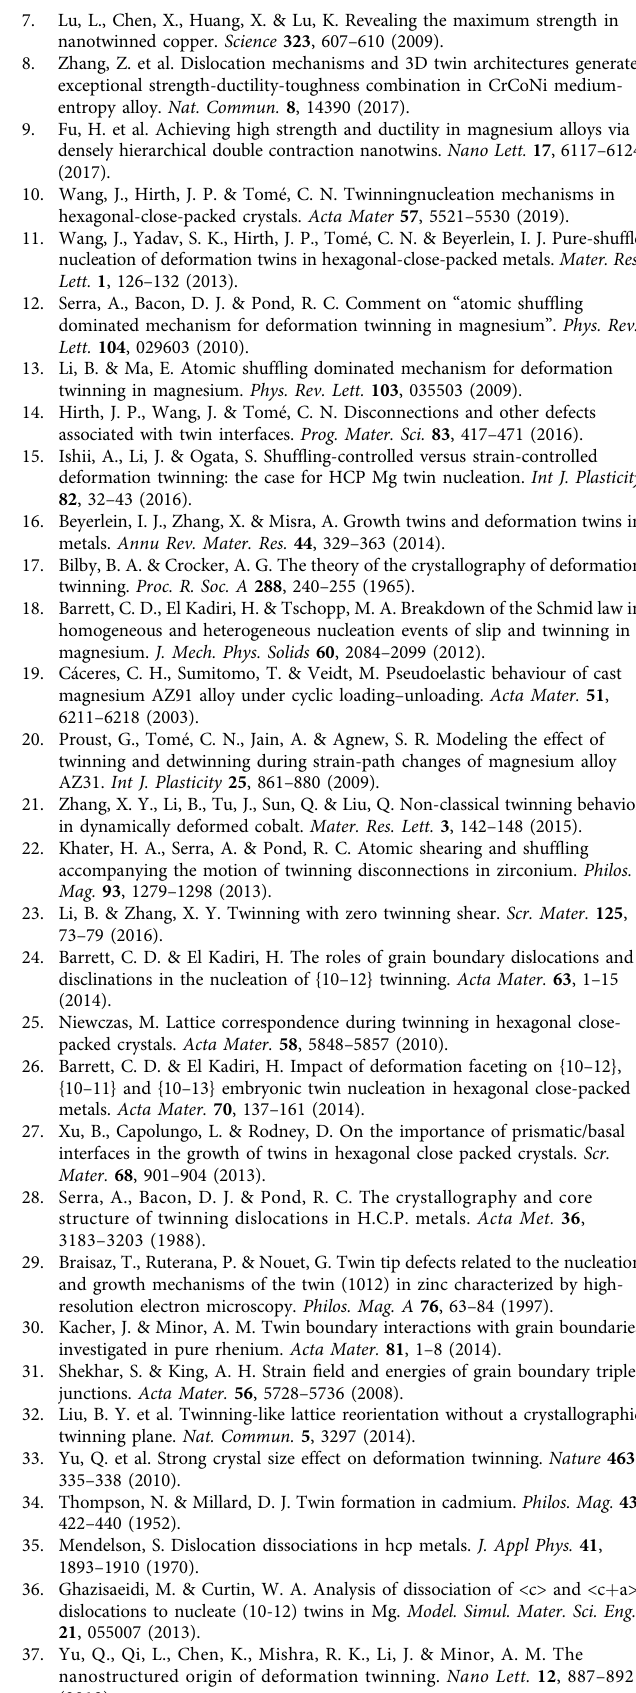
Fig. 5a generated compressive strains on the prismatic planes to the right of the dislocation core; in the subsequent compression of the crystal, a {1 0 − 1 2} twinning preferentially nucleated at the region where compressive strain of the dislocation core was the largest, demonstrating that the strain fi eld of matrix dislocations could prompt the twinning nucleation. It should be noted that a high compressive stress (~5 GPa based on a rough estimation 57 ) was attained at the moment of the twinning nucleation in Fig. 5b, which is not readily available in polycrystalline Re samples without signi fi cant stress concentrations 30 . Though, similar mechanism is expected to be present in nano-grains of HCP metals wherein high-stress-state can be